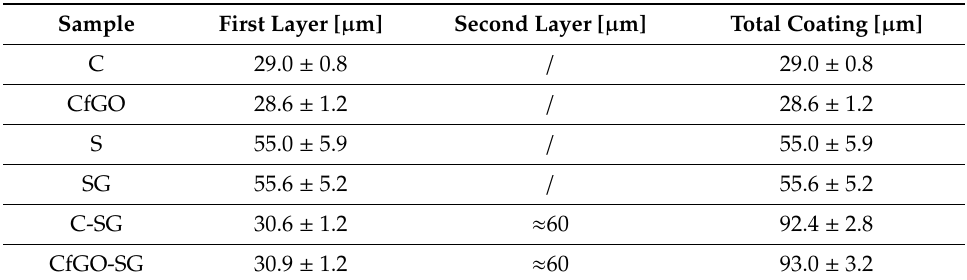
Table 2. Coatings thickness measured with the thickness